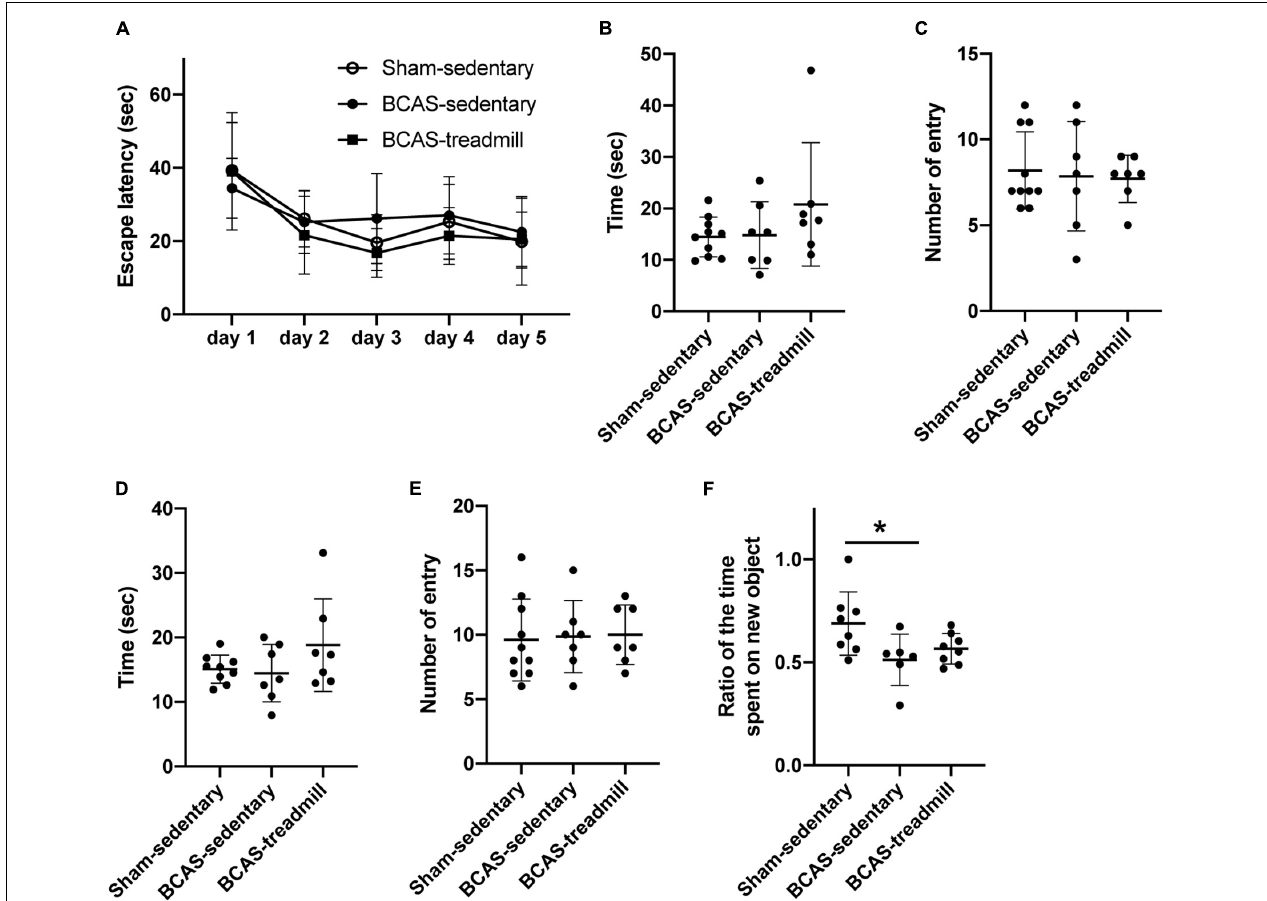
FIGURE 3 | Result of cognitive function test from Experiment 2. (A) During the acquisition phase of Morris water maze, no difference was observed in latencies to locate the hidden platform between the 3 groups (Sham/Sedentary vs. BCAS/Sedentary vs. BCAS/Treadmill). Data are mean ± SD. (B,C) Result of the probe trial (4 h after the last acquisition session) in the Morris water maze test. There were no significant differences in both (B) number of entries into and (C) time spent in the quadrant which formerly contained a hidden platform in the acquisition phase. Data are mean ± SD. (D,E) Result of the probe trial (24 h after the last acquisition session) in the Morris water maze test. There were no significant differences in both (D) number of entries into and (E) time spent in the quadrant which formerly contained a hidden platform in the acquisition phase. Data are mean ± SD. (F) Compared to the Sham/Sedentary group, the BCAS/Sedentary group showed less preference to the novel object (* p < 0.05, one-way ANOVA followed by post hoc Tukey’s test). However, there was no significant difference between Sham/Sedentary and BCAS/Treadmill groups. Data are mean ±